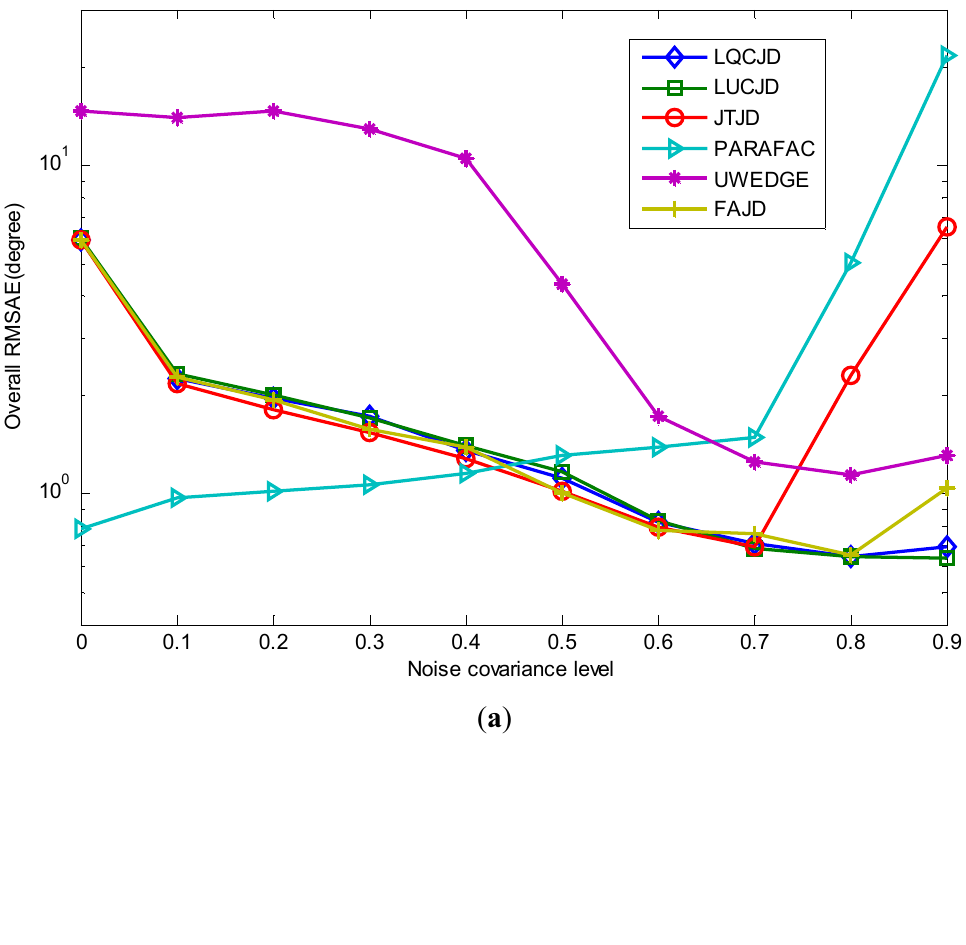
Figure 5. Performance of LUCJD, LQCJD, PARAFAC, UWEDGE, FAJD, JTJD versus the noise covariance level. SNR is 2 dB and the number of snapshots is 1,000. ( a ) The overall RMSAE curves of DOA estimates. ( b ) The overall RMSE curves of polarization amplitude angle estimates. ( c ) The overall RMSE curves of polarization phase difference angle